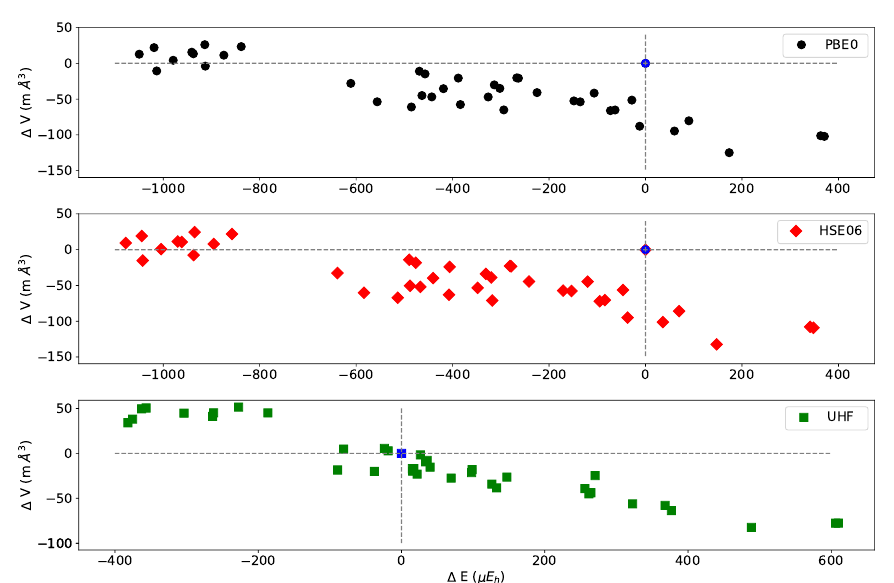
Figure A2. Relative volume versus relative total energy with respect to REF (blue symbol) of the symmetry independent classes (SIC) belonging to the (2,3,3) CEC, for 3 functionals: PBE0, HSE06, and UHF. Volume and energy per 2